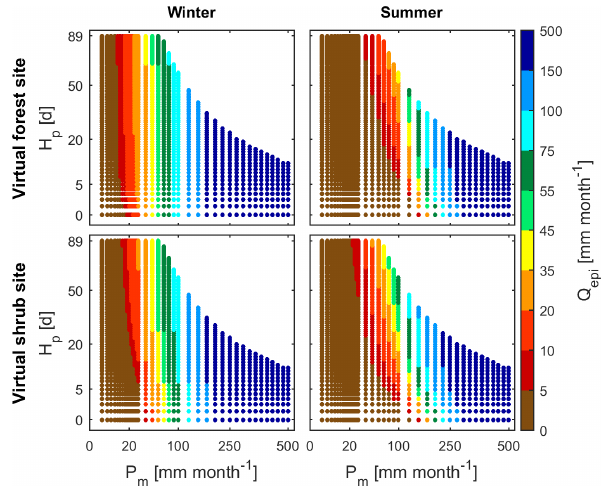
Figure 8. Average monthly recharge ( Q epi ) simulated with V2Karst for different values of average monthly precipitation P m (mmmonth − 1 ) and the interval between wet days H p (days) of the synthetic periodic precipitation input used to force the model, at the virtual forest and shrub sites and under winter and summer condi- tions.